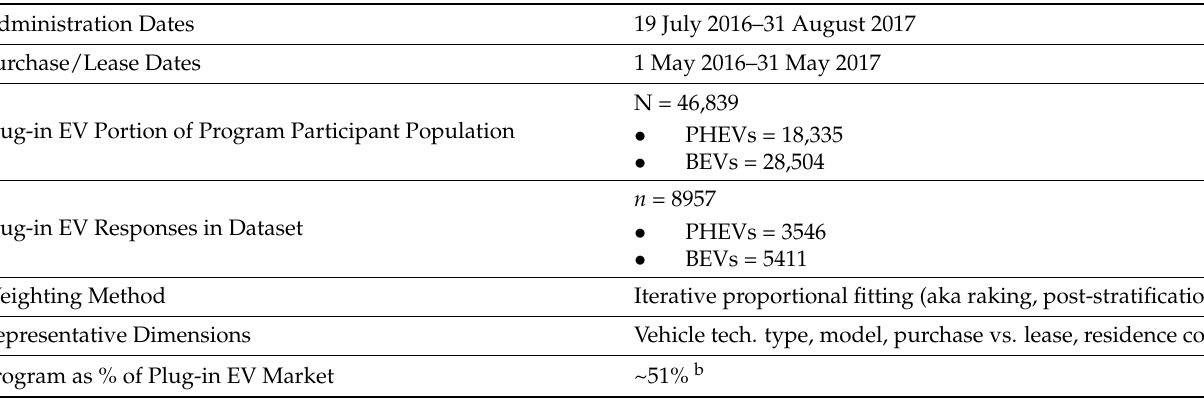
Table 1. California CVRP Consumer Survey, 2016–17 Edition a